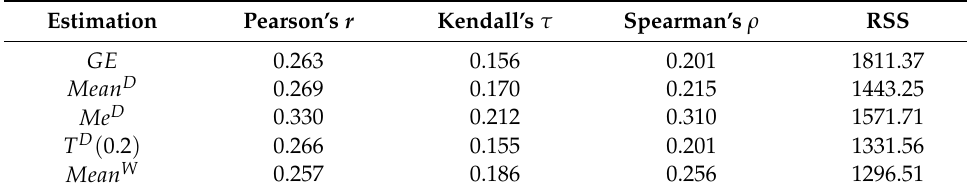
Table 8. Evaluation of models with 33 missing